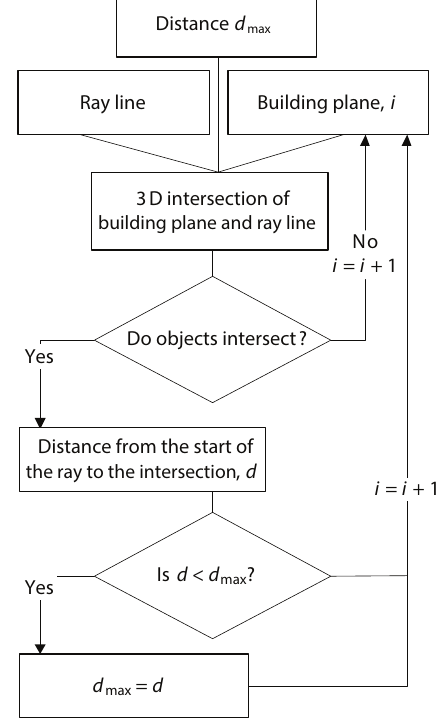
Fig. 1. Algorithm scheme for determining the nearest intersection